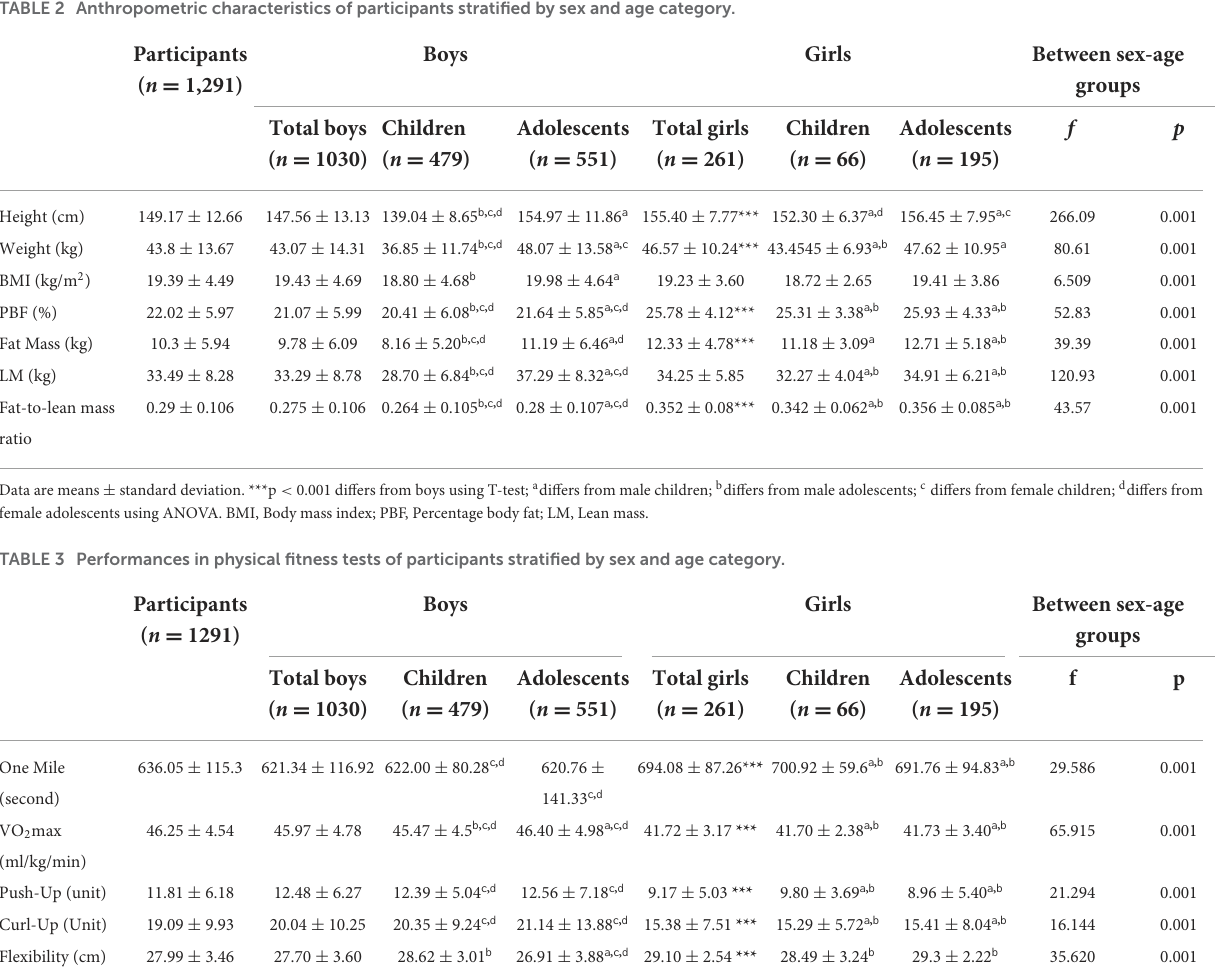
TABLE 2 Anthropometric characteristics of participants stratified by sex and age category.